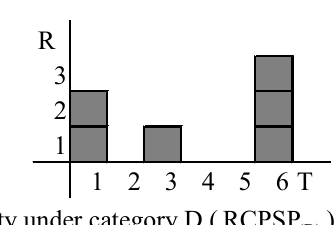
RCPSP ). Fig. 2. Activity under category B ( (A)